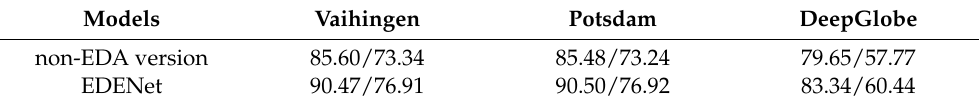
Table 7. Ablation study’s results. The accuracy is presented in the OA/mIoU